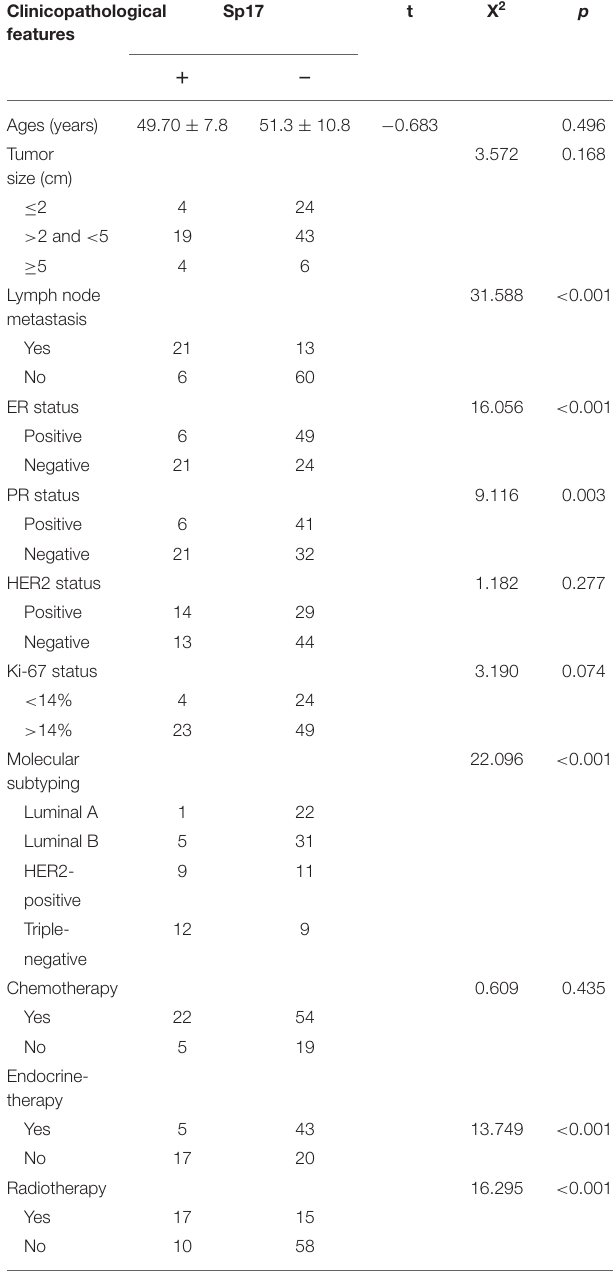
TABLE 1 | Association between Sp17 expression and clinicopathological features—univariate